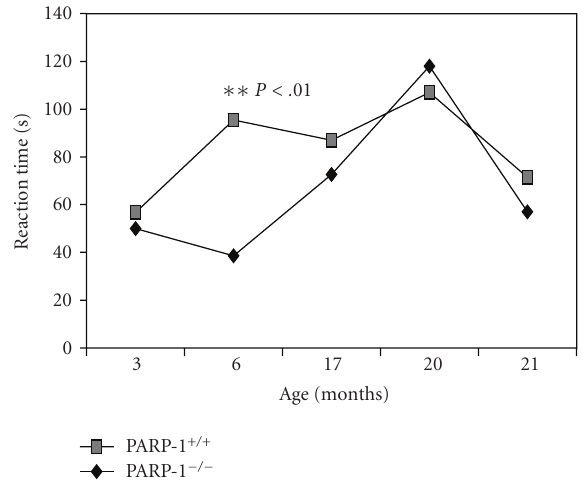
Figure 5: Age-related behavior (standing reaction duration) in “open field” test in PARP-1 − / − and PARP-1 + / + mice. The vertical axis represents the standing reaction duration at indicated age. Student’s t test was performed to analyze the statistical significance of the